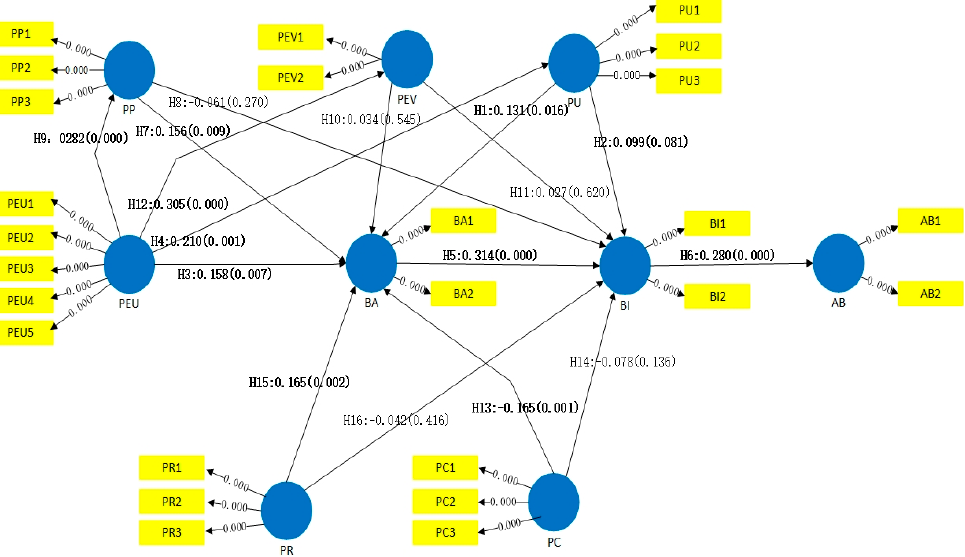
Figure 3. Structural model and path coefficients. Table 8. Structural model results.